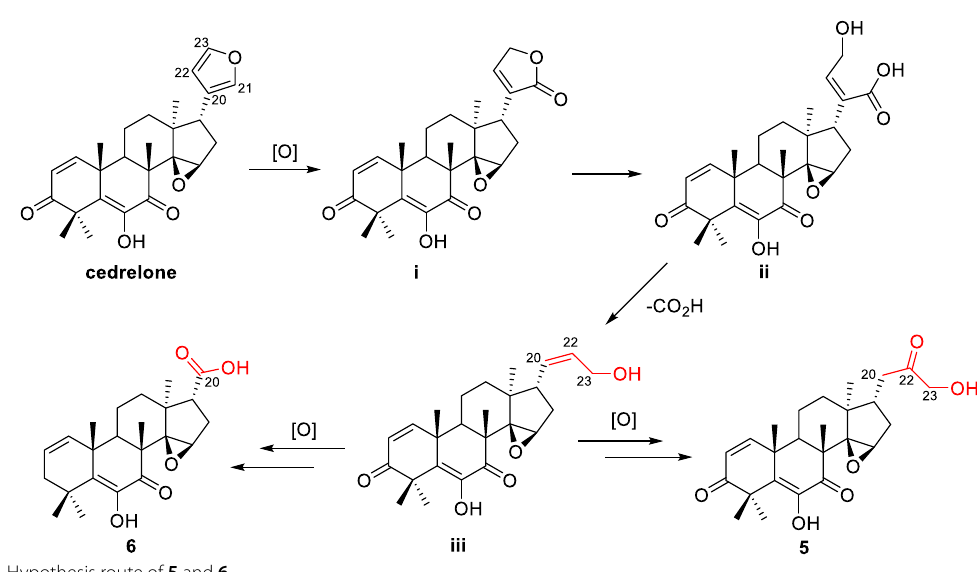
Scheme 1 Hypothesis route of 5 and